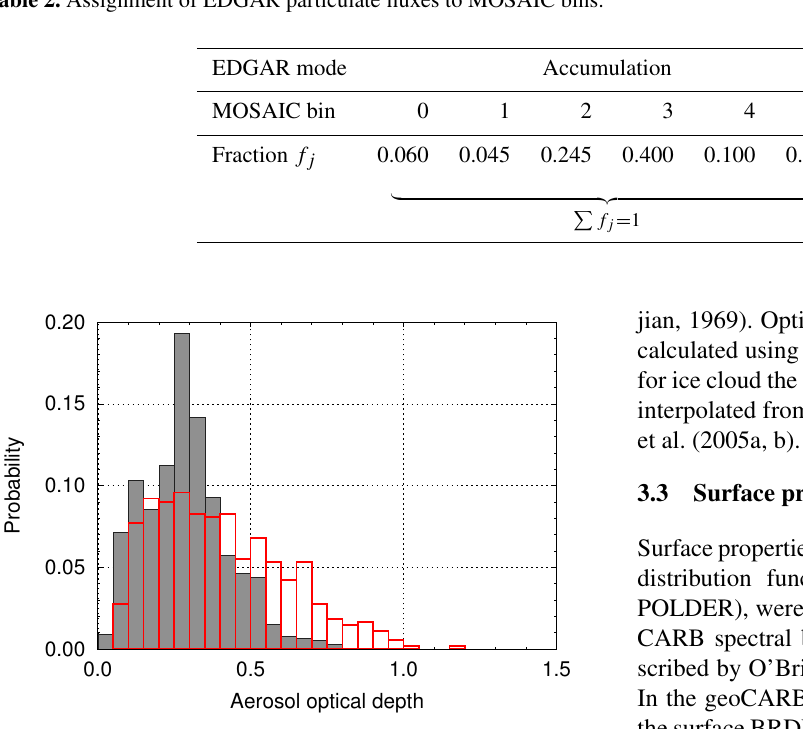
Figure 4. Histograms of aerosol optical depth over Shanghai from the WRF-Chem simulations (grey) and from MODIS (red). The wavelength is 770 nm.